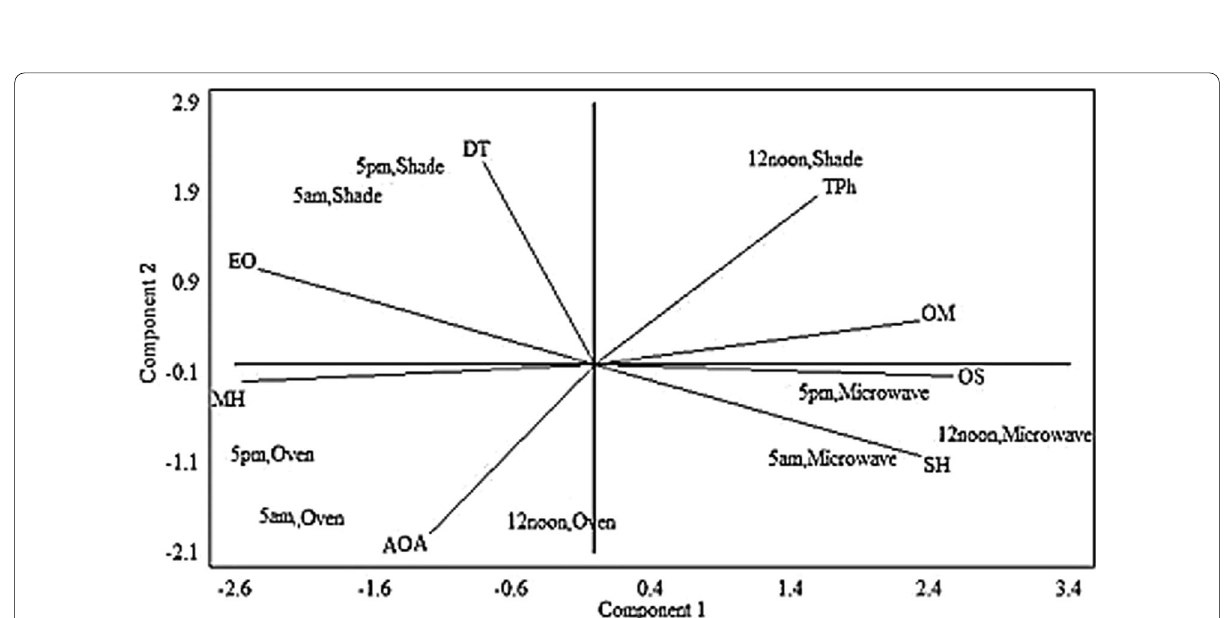
Fig. 3 Biplot of the different treatments based on the evaluated